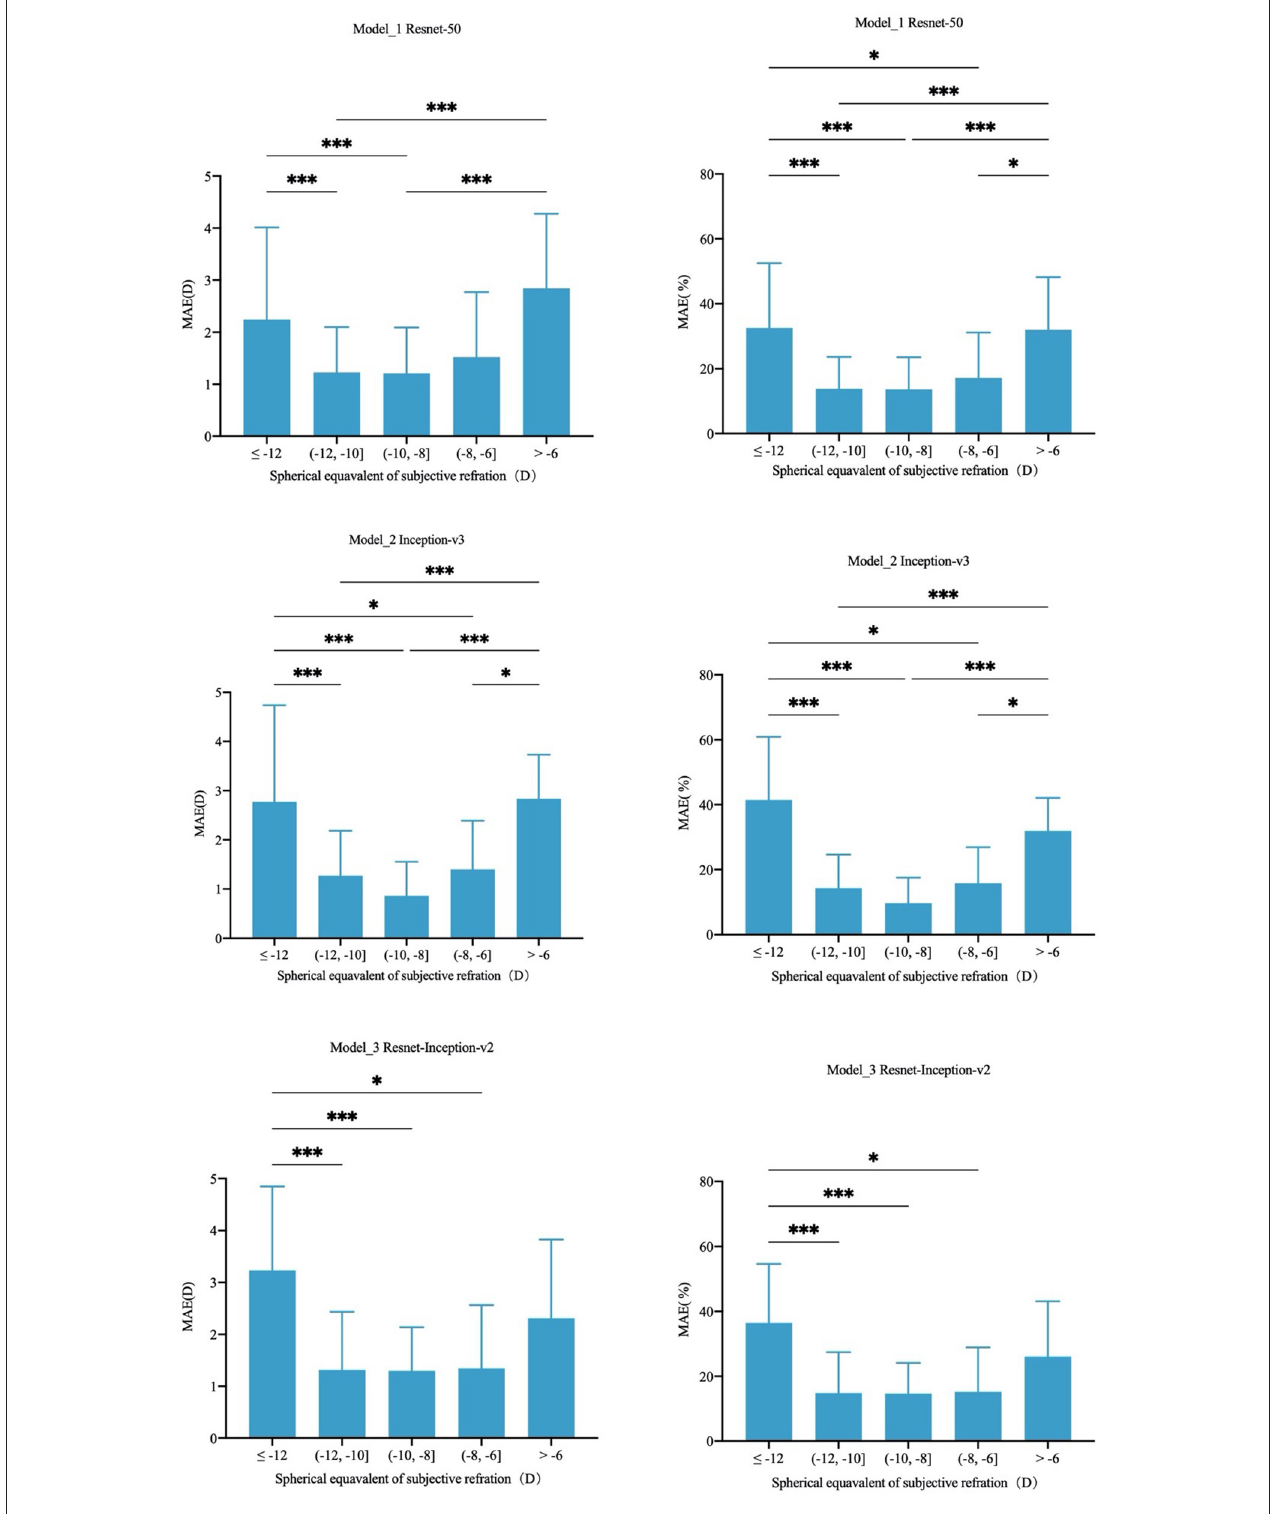
FIGURE 3 | Comparison of MAE and MAPE in different refractive error groups. * P < 0.05, *** P < 0.001.